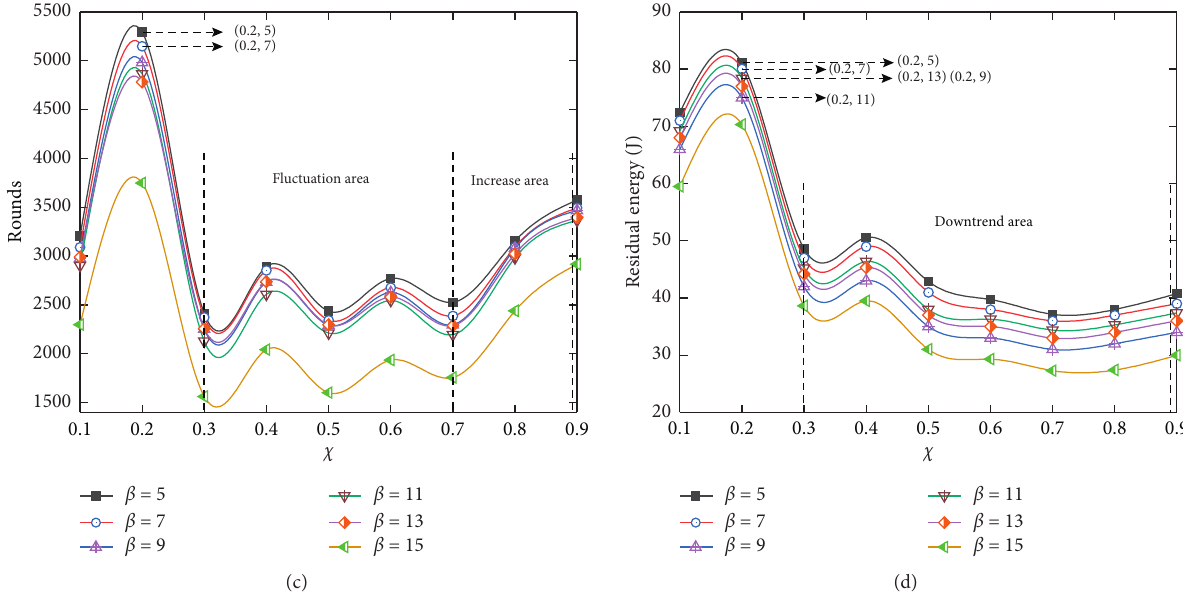
Figure 11: Relationships between [ χ, β ] and assessment metrics: (a) impact of [ χ, β ] on the death round of the first node, (b) impact of [ χ, β ] on the death round of half nodes, (c) impact of [ χ, β ] on the death round of 80% nodes, and (d) impact of [ χ, β ] on residual energy.